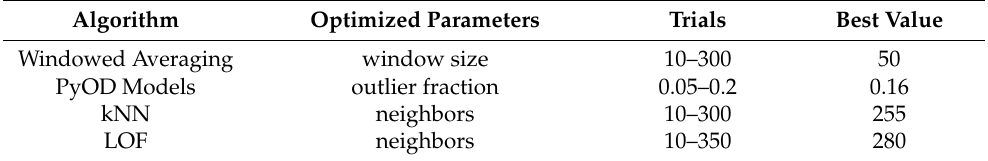
Table 2. Simulation parameters.